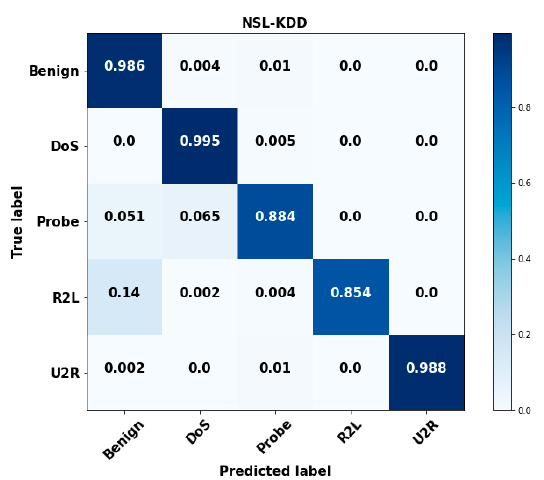
Figure 12. Confusion matrix for dataset 1.